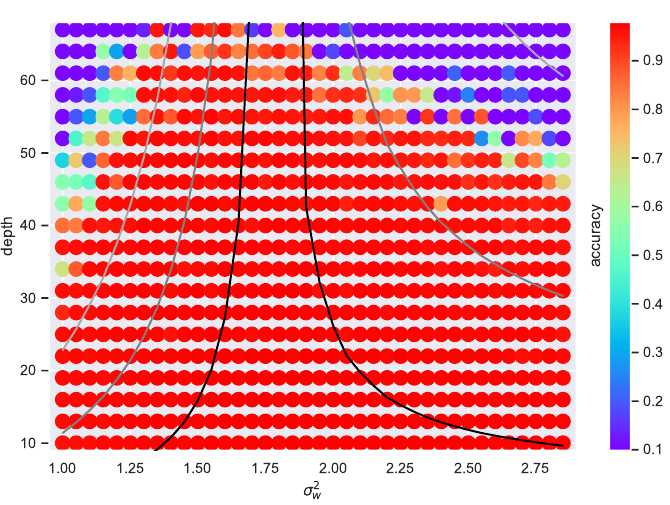
Figure 6: Classification accuracy on MNIST after 15 epochs of training as a function = 0.05, for which the critical point χ = 1 lies at σ 2 ≈ 1.76 of σ 2 and depth for σ 2 1 w w b (at N → ∞ ). The theoretical value of 1, π , and 2 π times the correlation length are overlaid in black, grey, and light grey, respectively. Note that we can train deeper networks closer to criticality; the maximum trainable depth falls off the further we (cid:174) 1.76) or chaotic ( σ 2 (cid:166) 1.76) phase. This serves as a move into the ordered ( σ 2 w w sanity check that our networks exhibit the same qualitative behavior observed in [ 24 ] , cf. fig. 5 therein, which depicts a more thorough exploration (because this is the best we could do before hitting Colab’s resource